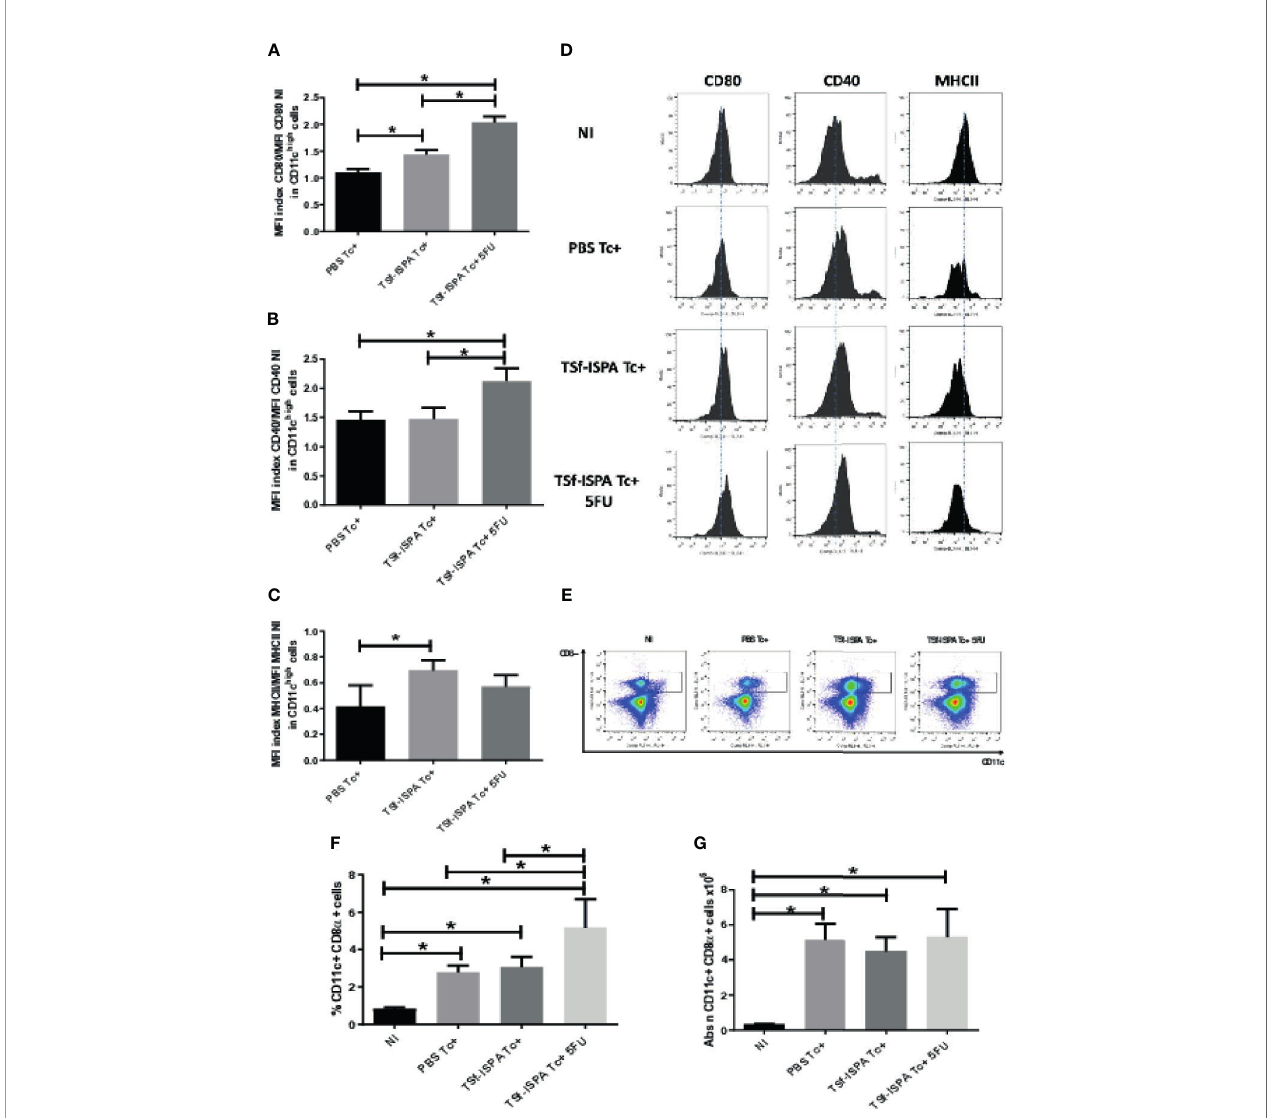
FIGURE 5 | MDSC depletion and dendritic cells. Mice immunized with TSf-ISPA or PBS were treated or not with 5FU and challenged with 900 trypomastigotes of the Tulahuen strain. At day 21 p.i., mice were sacri fi ced to analyze the expression of CD11c, CD80, CD40, MHCII and CD8 a by FACS in control non-infected (NI), PBS-inoculated and infected mice (PBS Tc+), TSf-ISPA immunized and infected mice (TSf-ISPA Tc+) and TSf-ISPA immunized, infected and 5FU treated mice (TSf- ISPA Tc+ 5FU). (A) Index of MFI CD80/MFI CD80 of non-infected mice in CD11c high cells. (B) Index of MFI CD40/MFI CD40 of non-infected mice in CD11c high cells. (C) Index of MFI MHCII/MFI MHCII of non-infected mice in CD11c high cells. (D) Representative histograms of the expression of CD80, CD40 and MHCII in CD11c high cells in the experimental groups of mice under study: (E) Representative dot plots of the expression of CD11c and CD8 in the experimental groups of mice. (F) Percentage of CD11c+ CD8 a + DCs. (G) Absolute number of CD11c+ CD8 a + cells in the spleen x10 6 . Data are expressed as means + standard deviations. The results are representative of two independent experiments (n = 3-5 mice per group, according to the survival of the experiment). *p < 0,05 between indicated groups of